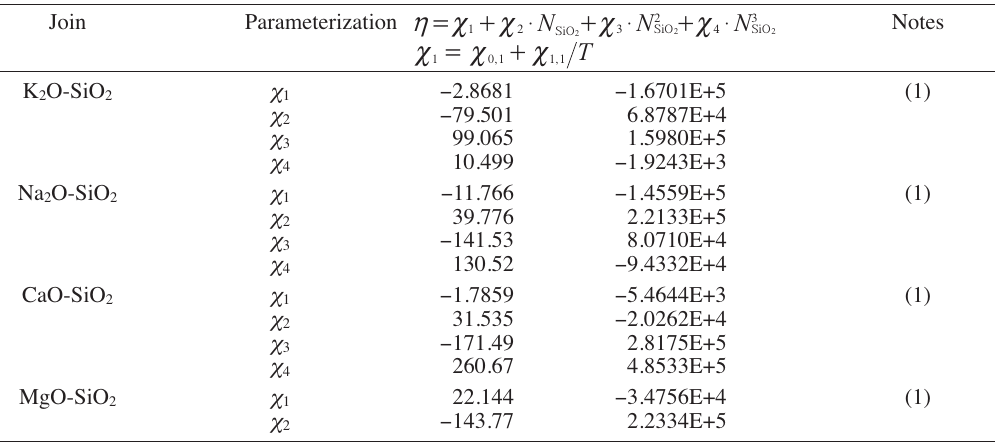
Table VI. Strain energy of HPM (from Ottonello and Moretti,